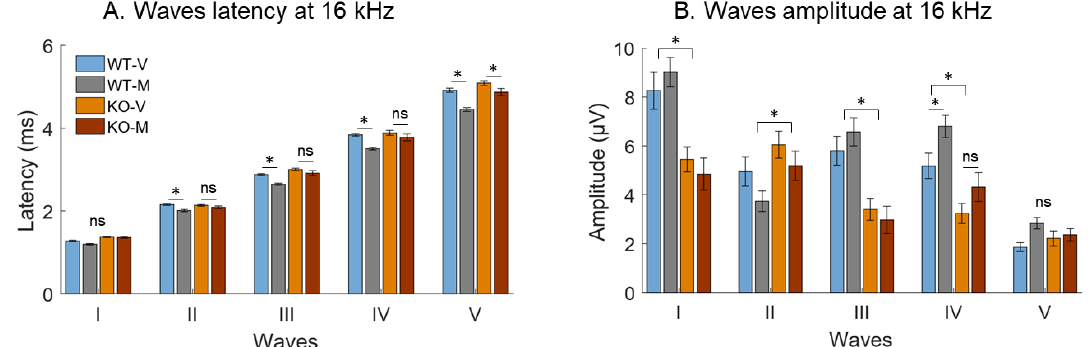
Figure 3. The mean latency and mean amplitude of the five ABR waves at 16 kHz at 70 dB. ( A ) Latency distribution of waves I to V for each group at 16 kHz. The latencies of waves II to V were significantly shorter in the WT mothers compared to the WT virgins. Wave latency in the TPC KO mother mice was only shorter at wave V compared to the TPC KO virgins. ( B ) The amplitude distribution of waves I to V for each group at 16 kHz. The amplitudes of waves were not different between the virgin and mother mice (WT and TPC KO), except for wave IV between the WT virgins and WT mothers. The wave amplitude between the WT and TPC KO mice also differed for four of the five ABR waves. The * indicate significant difference ( p < 0.05) and ns indicate non-significant effects.